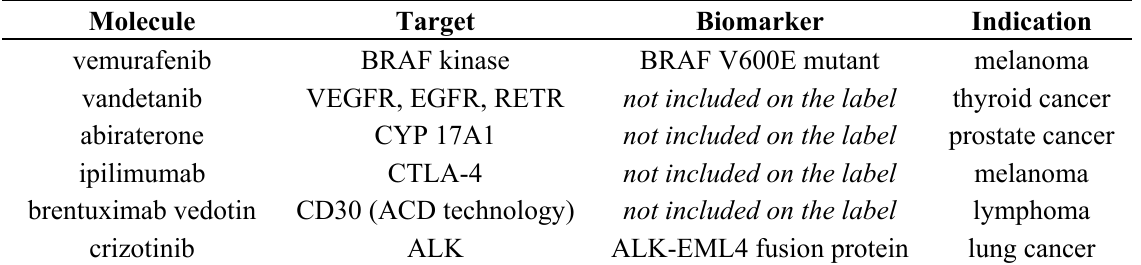
Table 1. New cancer drug approvals in 2011 (source: Food and Drug Administration (FDA)).